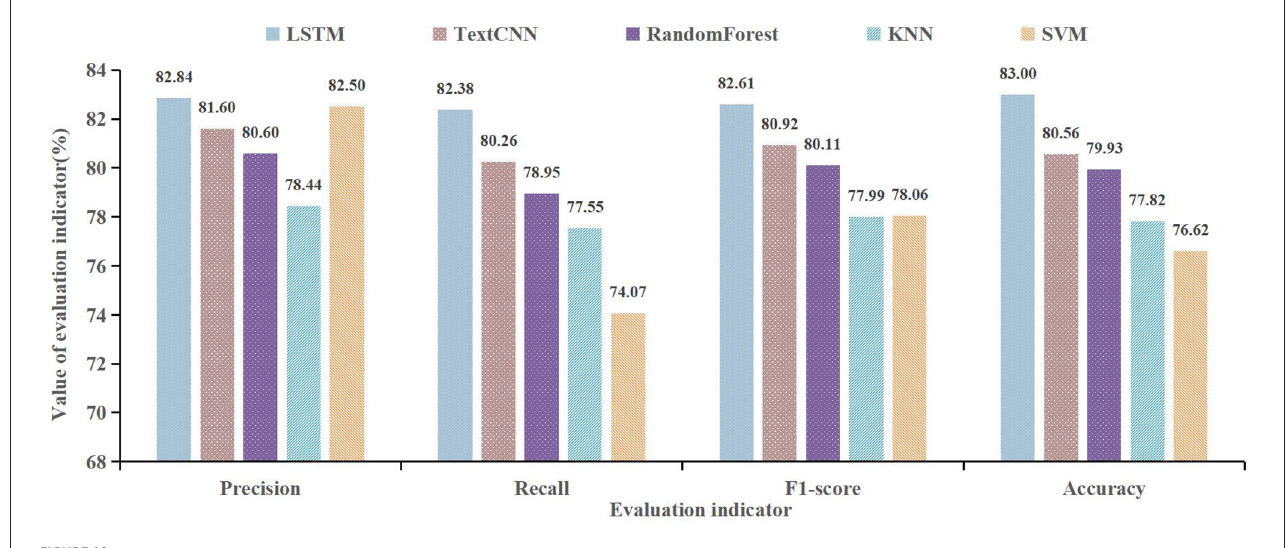
FIGURE10 Classification effect of multiple